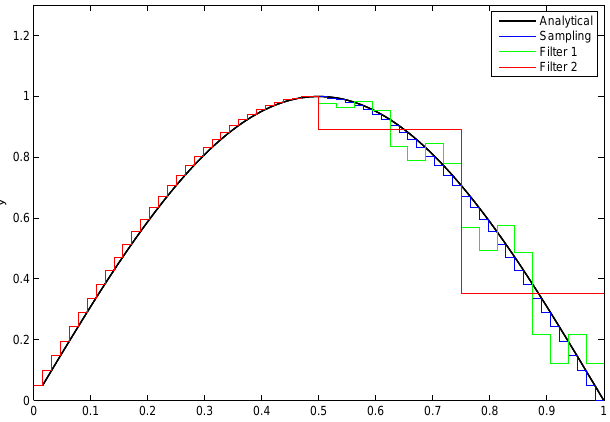
Figure 2. Signal representation with different wavelet coefficient